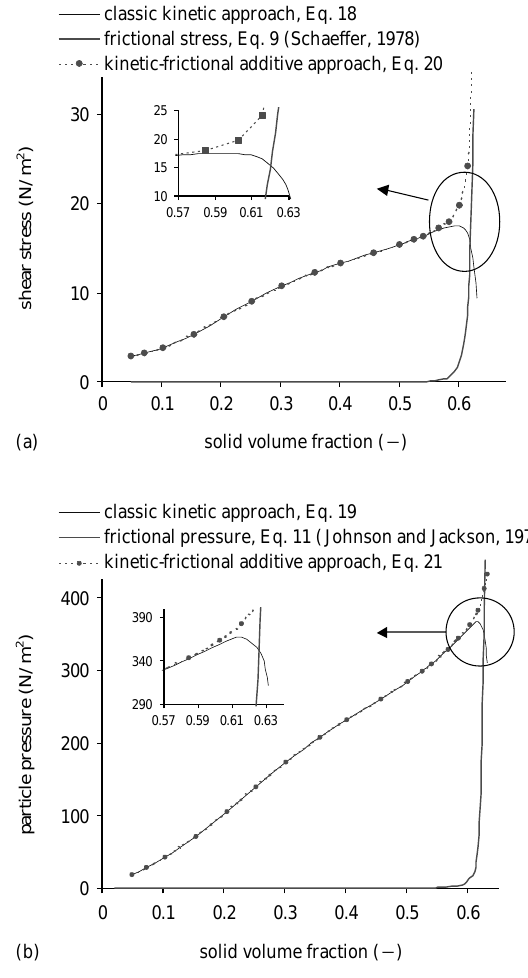
Critical additive approach of particle stresses (a) shear stresses (b) particle